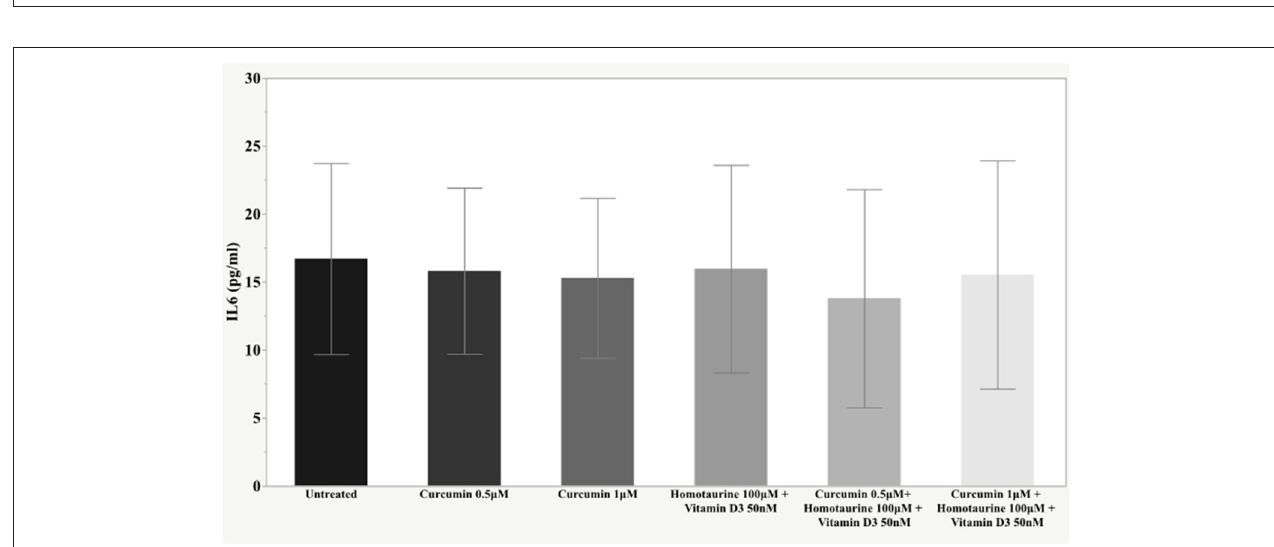
FIGURE 4 | Histogram of the mean and standard deviations of IL6 by experimental